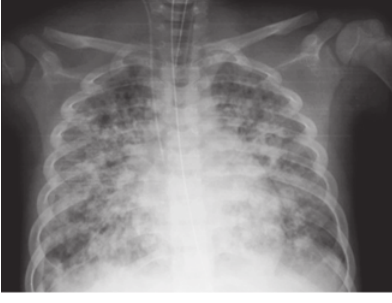
Figure 1. Chest radiograph shows multiple bilateral pulmonary infiltrates suggesting an acute respiratory distress